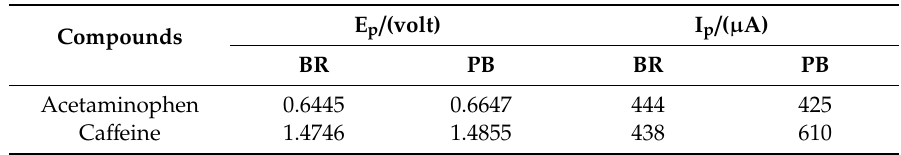
Table 4. Potential peak (Ep) and peak current (Ip) of acetaminophen and ca ff eine 1 mM in bu ff er pH 2, BR 0.04 M and PB 0.04